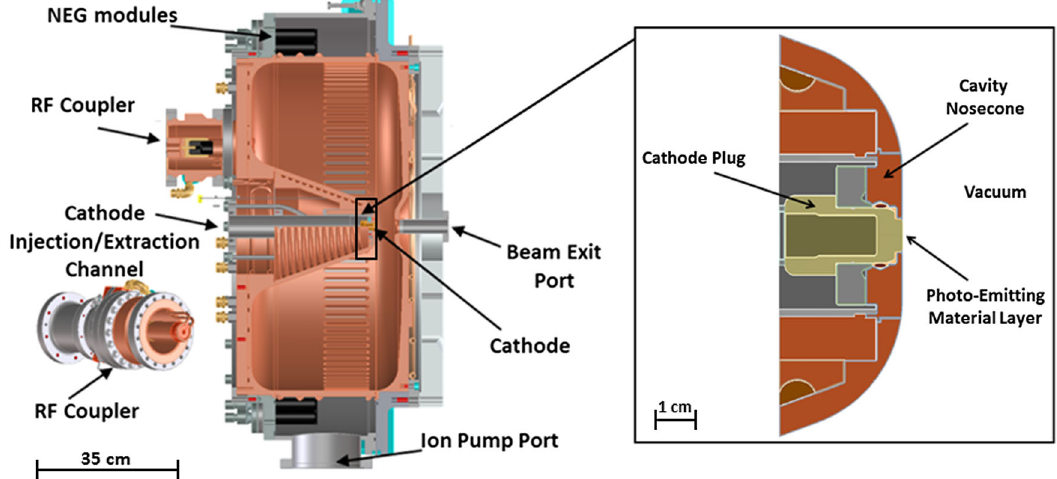
FIG. 1. Cross section of the APEX VHF gun with its main components in evidence. The inset shows the detail of the cathode plug